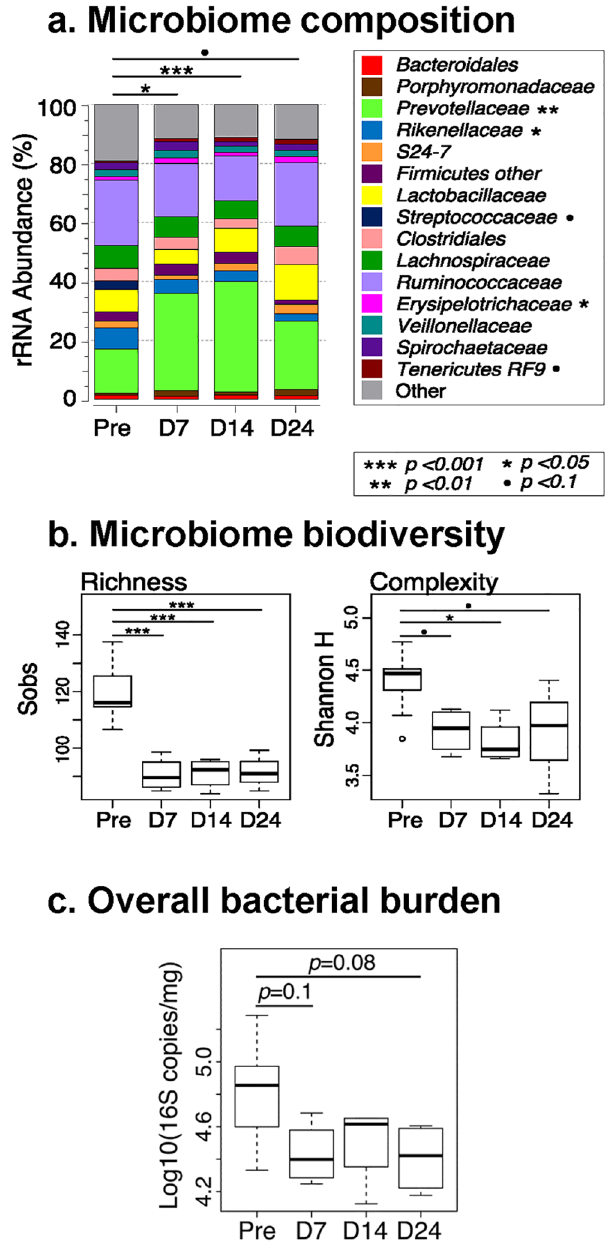
Fig 8. Rifaximin (RFX) treatment alters the gut microbiome. Broad-range 16S rRNA amplification and high-throughput sequencing was used to profile fecal microbiota before (Pre), during (D7, D14), and following (D24) treatment, as described in the text. (a) Summary of the family-level distribution of bacterial taxa (expressed as percent relative abundance) averaged across each group. Lines and symbols above the stacked bars indicate significant differences in microbial composition assessed by PERMANOVA tests of Bray-Curtis similarity scores. Individual taxa that differed significantly in abundance across timepoints, as assessed by Kruskal-Wallis tests, are indicated in the legend. (b) Comparison of two measures of biodiversity (richness and complexity), inferred from 16S rRNA sequence datasets, between timepoints. Significance was assessed by Welch Two Sample t-test. (c) Boxplots summarizing the log10-transformed bacterial loads measured in fecal samples by 16S rRNA gene PCR and normalized to fecal weight. Bacterial loads differed across all four timepoints (ANOVA p = 0.04). Pairwise comparisons with P-values less than 0.1 are